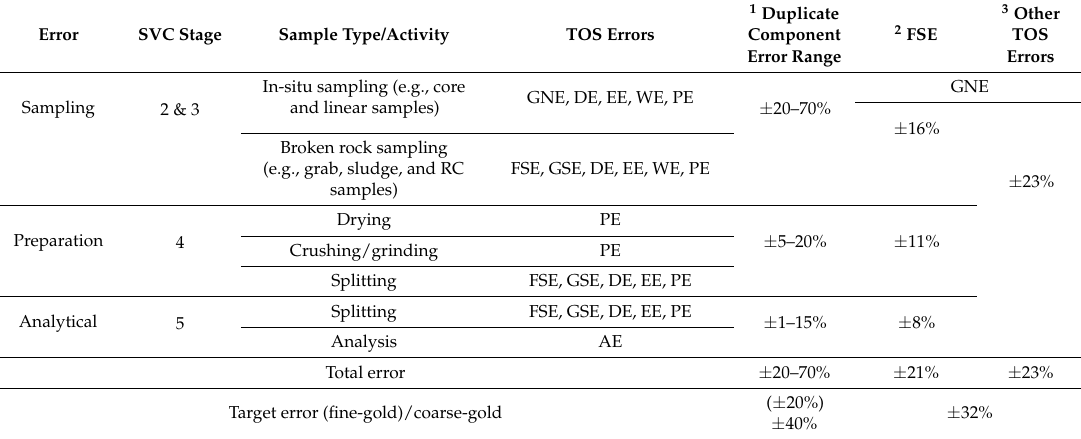
Table 4. Distribution of errors across stages of a gold grade control sampling programme. Refer to Table 1 for the sampling value